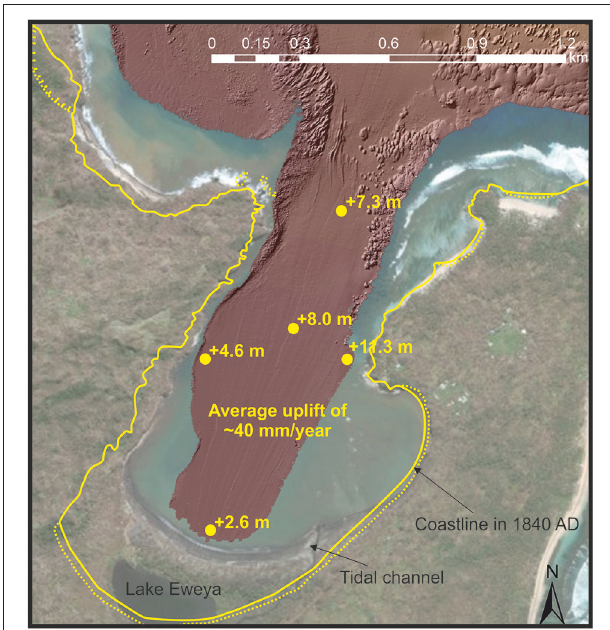
FIGURE 9 | Comparison of satellite photography and bathymetry of Resolution Bay acquired in 2017, compared with outline of coastline from mapping by Captain Belcher in 1840 in yellow (Hydrographic Office of the Admiralty, 1843 ). Filled circles illustrate comparison between bathymetric soundings in 1840 and 2017, which show an average elevation difference of + 6.8m; equating to an annual average rise of 40